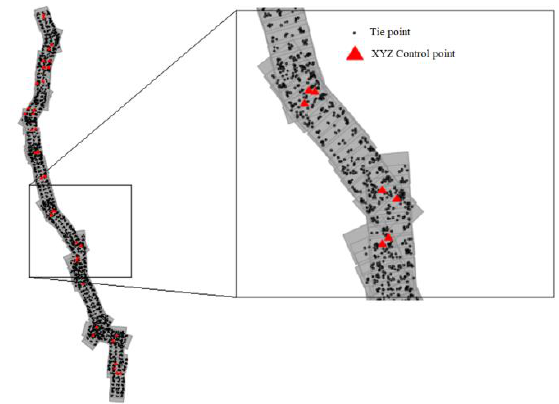
Figure 6. The layout of the independent image block.